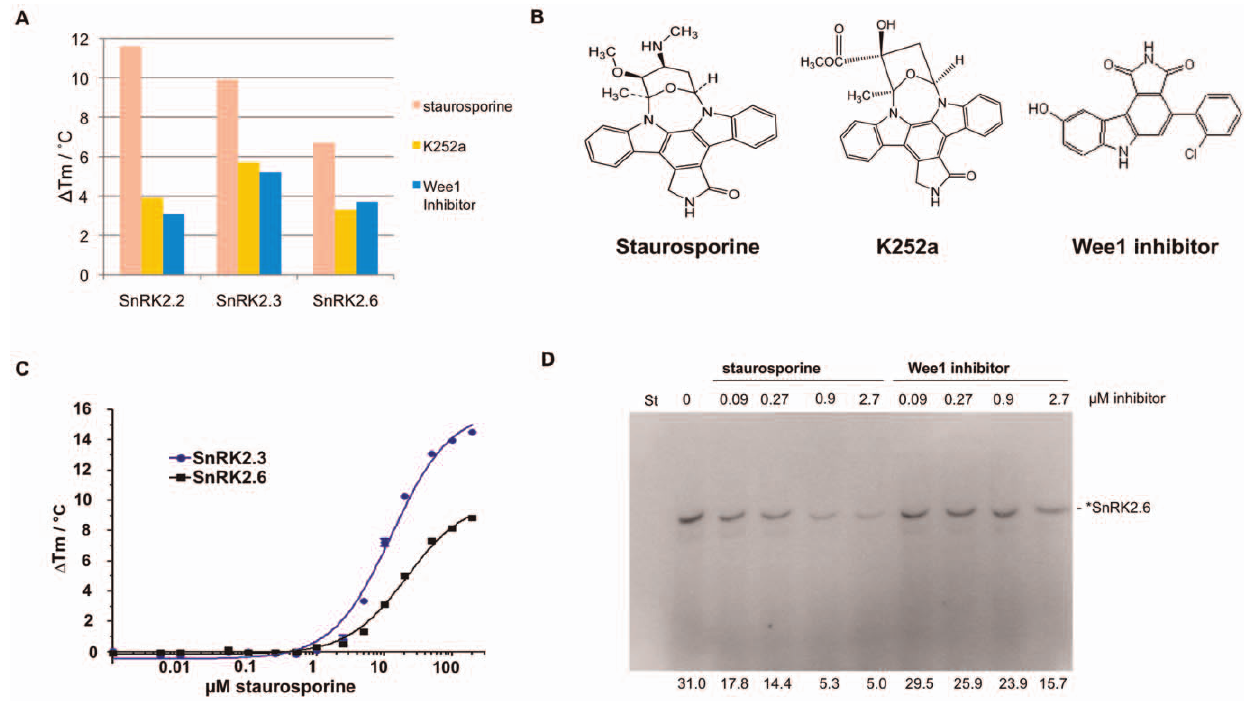
Figure 8. Increase in thermal stability of SnRK2s upon binding of kinase inhibitors. ( A ) Incubation with staurosporine, Wee1 inhibitor, and K-252a shifted the Tm of all three ABA-signaling SnRK2s. ( B ) Chemical structure of the kinase inhibitors that stabilized and increased the Tm of SnRK2.2, 2.3, and 2.6 kinases by at least 3 u C. ( C ) Dose-dependent stabilization of 5 m M SnRK2.3 and SnRK2.6 by staurosporine. ( D ) Inhibition of SnRK2.6 autophosphorylation by staurosporine and Wee1 inhibitor in a radioactive kinase assay. 100 nM SnRK2.6 were incubated with [ 32 P]- c -ATP and increasing concentrations of kinase inhibitors. Reactions were separated by SDS PAGE and dried gels exposed to PhosphorImager screens. A densitometric quantitation of autophosphorylation bands is shown below the